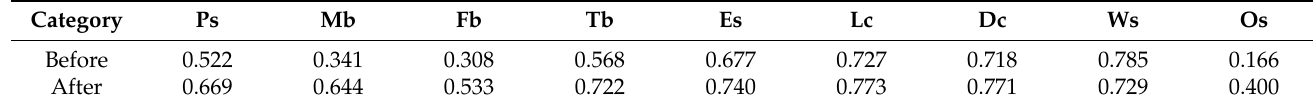
Table 7. AP values of various targets detected in the model before and after